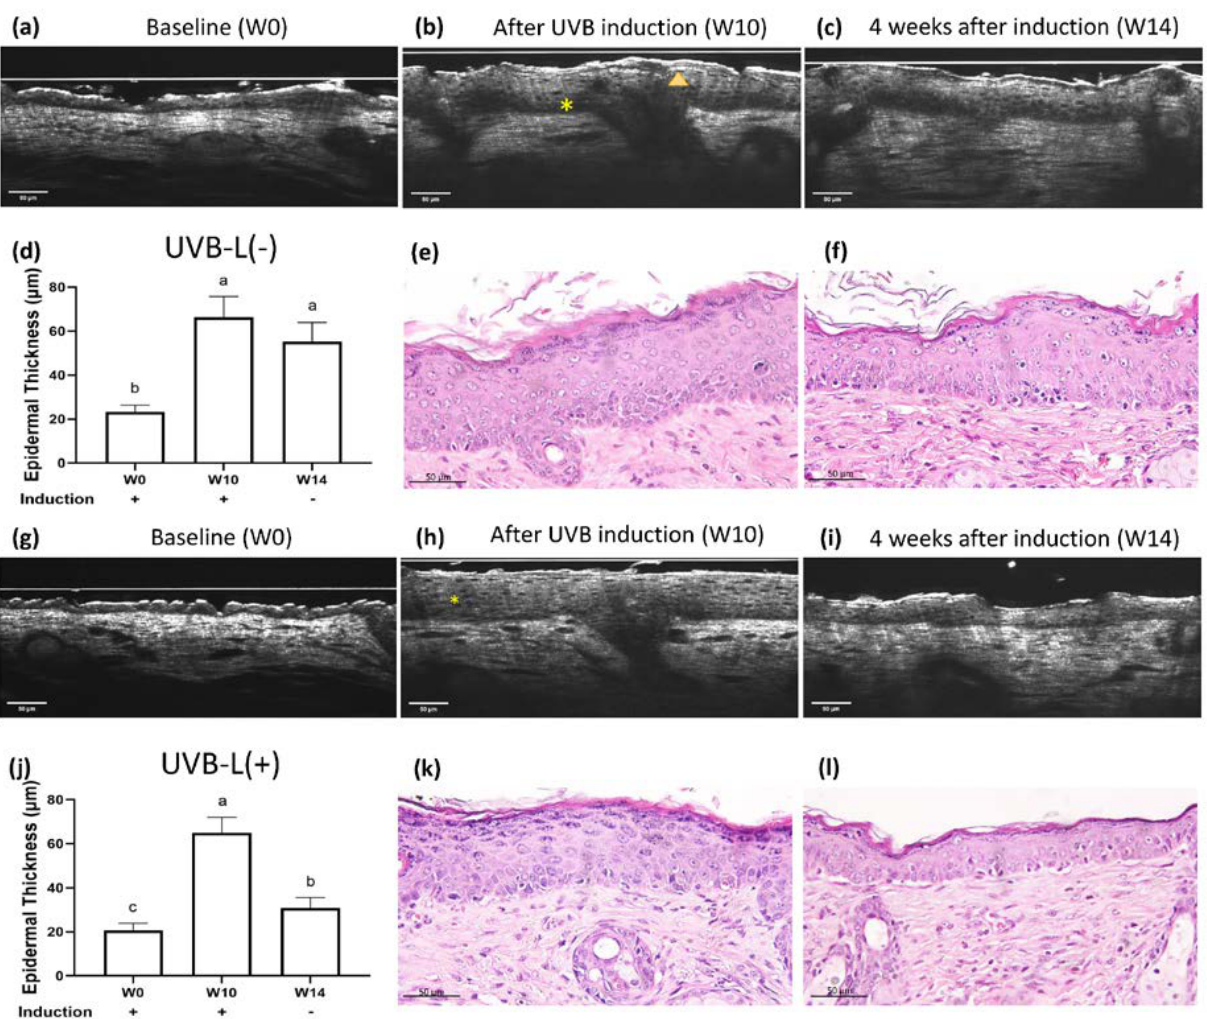
Figure 3. Real-time OCT and histology images of UVB-irradiated nude mice at ( a ) baseline (W0), ( b ) complete UVB induction (W10), and ( c ) 4 weeks after spontaneous recovery (W14). The UVB-L(+) group mice received laser immediately after UVB induction. Real-time OCT images of the UVB-L(+) group nude mice at ( g ) W0, ( h ) W10, and ( i ) W14. UVB irradiation resulted in hypergranulosis (ar- rowhead) and thickened epidermis with nuclei irregular in size, shape, and orientation (*). ( e , k ) After UVB irradiation, significant hypergranulosis, epidermal acanthosis, intercellular edema, occasional apoptotic cells, and mild exocytosis of lymphocytes were observed. Loss of cell polarity with enlarged hyperchromatic nuclei was prominent in the basal layer. ( f , l ): The lasered group ( l ) regained cell polarity and demonstrated decreased epidermal thickening/hypergranulosis, while the non-lasered group ( f ) still showed significant hypergranulosis, epidermal acanthosis, and loss of cell polarity. ( d , j ) Different letters indicate statistically significant differences ( p < 0.05). The UVB-L(+) group showed significantly diminished epidermal thickening than the UVB-L( − ) group.